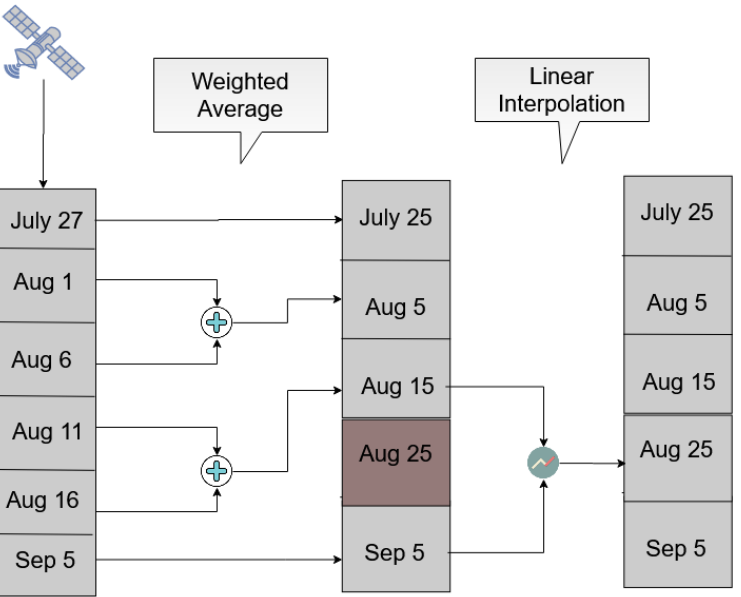
Figure 8. An example of the Sentinel-2 temporal interpolation methodology for images acquired between 20 July and 10 September